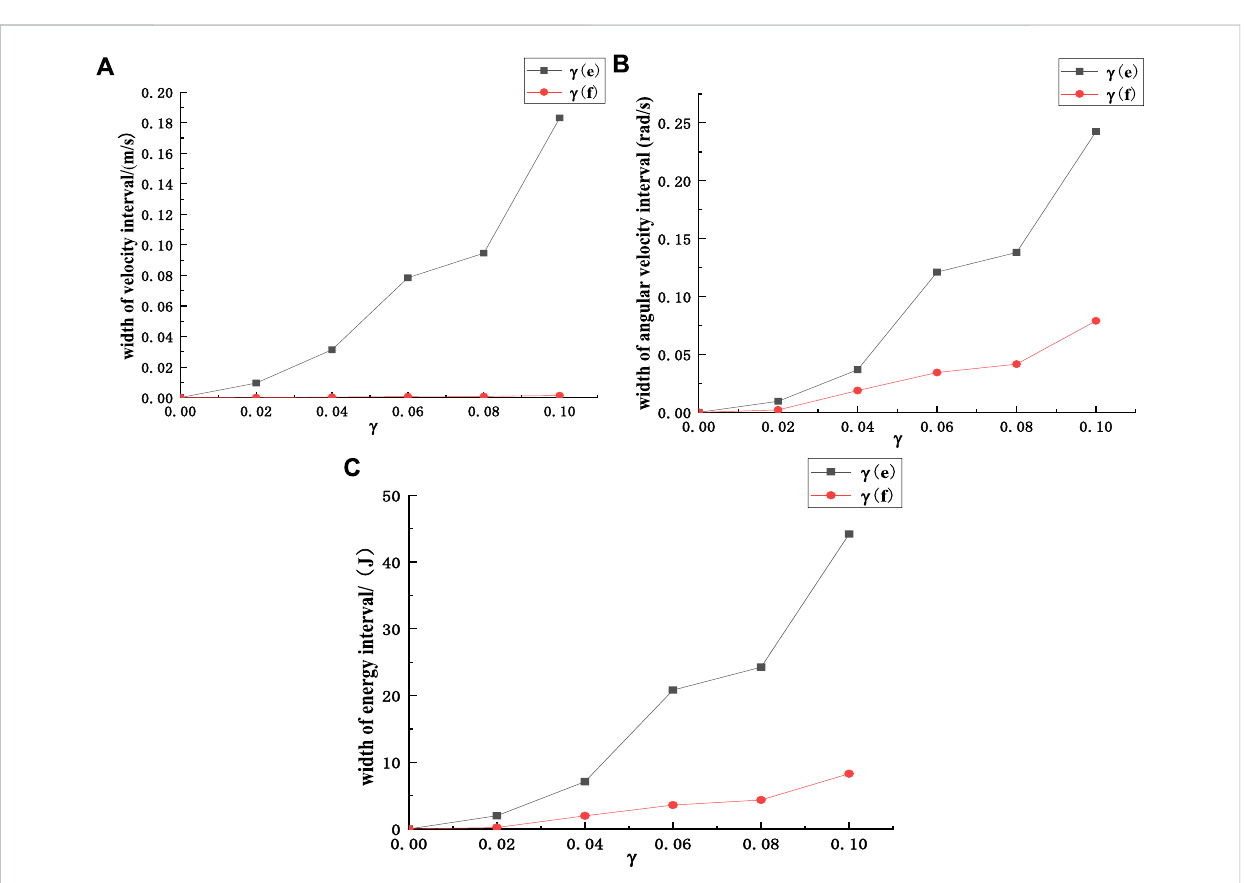
FIGURE 13 Kinematics characteristic quantity of rockfall, (A) Variation curve of velocity interval width of rockfall, (B) Variation curve of angular velocity interval width of rockfall, (C) Variation curve of energy interval width of rockfall.